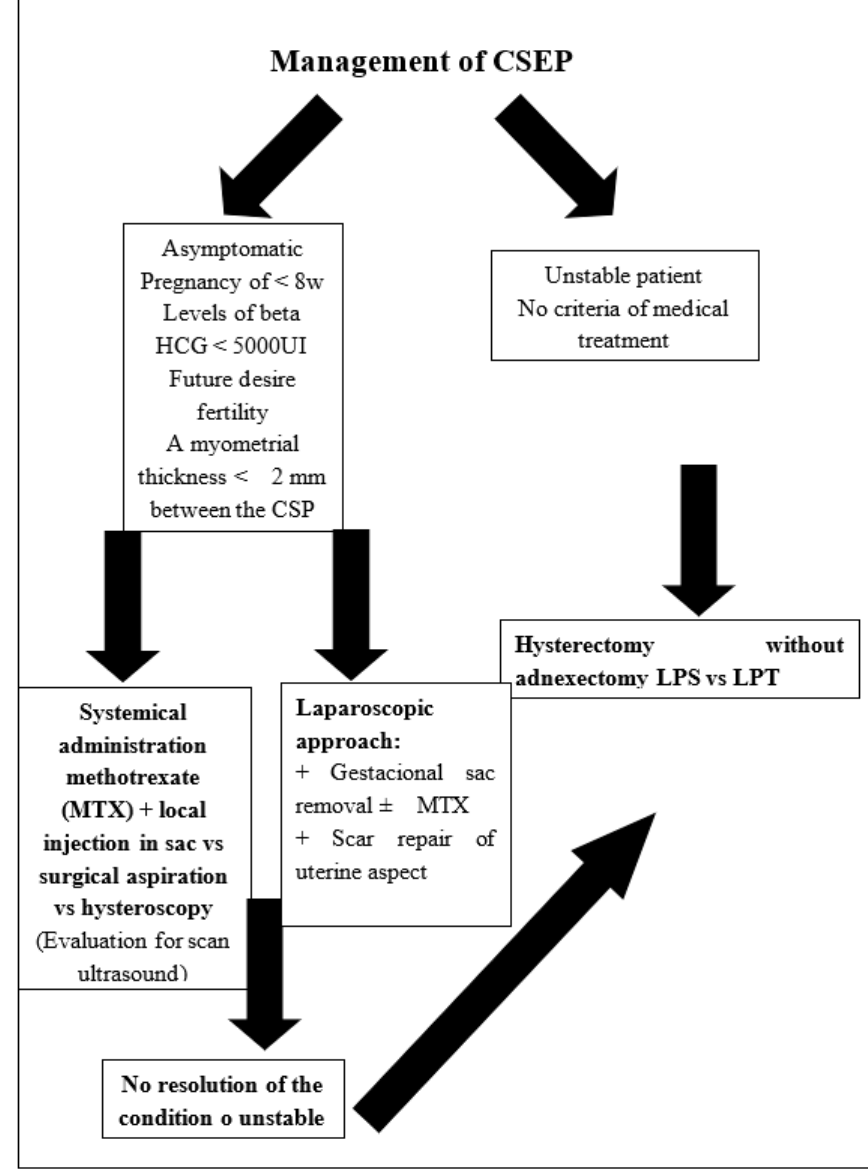
Figure 8. Management of CSEP; LPS: Laparoscopy , LPT: Laparotomy HCG: BetahCG.